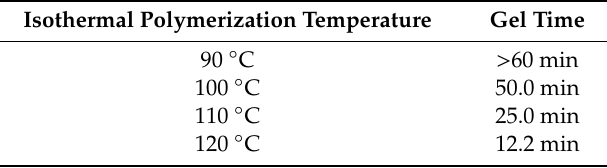
Figure 3. Dynamic mechanical analysis (DMA) spectra for isothermal cure of 3BOP-daC12 benzoxazine resin. The intersection of G’ and G” is defined as the gel point. Table 1. Summary of resin gel time as a function of isothermal polymerization temperature.